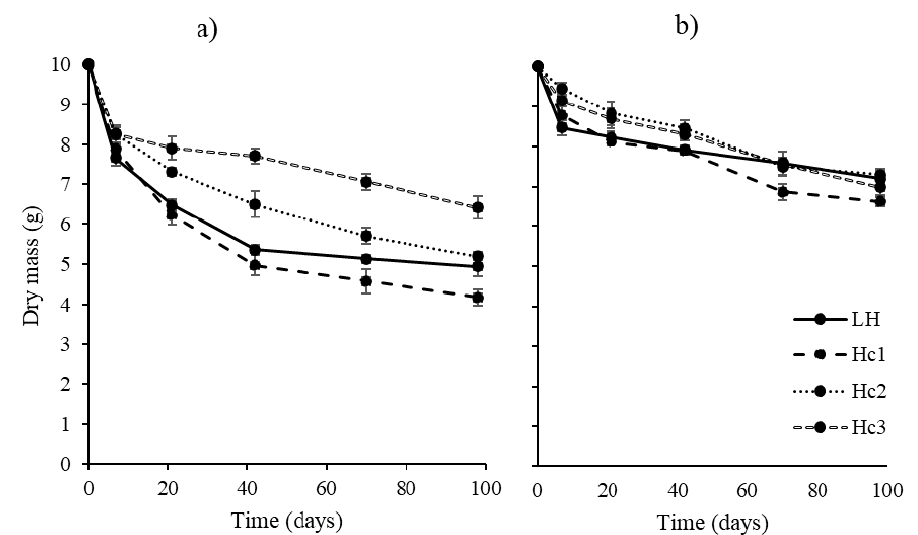
Figure 1. Changes in mean (± SE) leaf ( a ) and stem ( b ) mass loss (g) of goldenrod in Lake Hévíz (LH) and its canal (Hc1–3), n = 3.